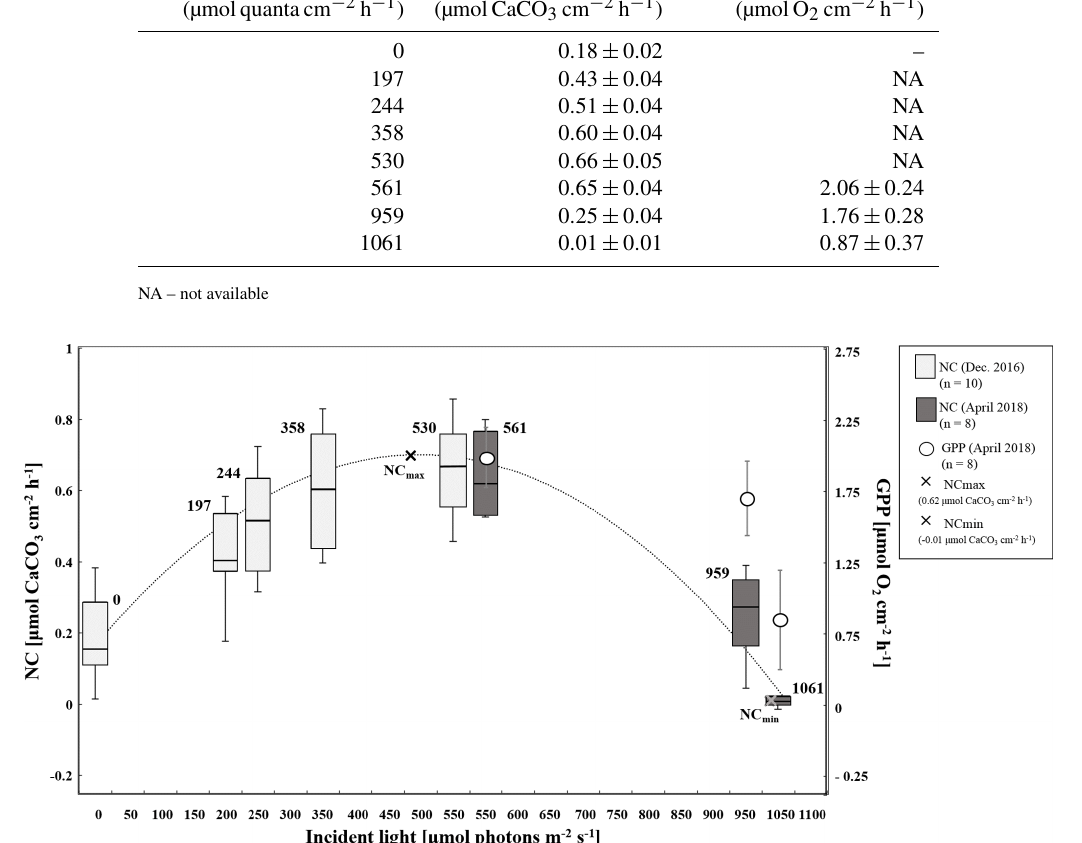
Figure 3. Boxplots showing net calcification rates (µmolCaCO 3 cm − 2 h − 1 ) of T. maxima under seven different light regimes (197, 244, 358, 530, 561, 959, and 1061µmolquantam − 2 s − 1 ) ( n = 10 in December 2016 and n = 8 in April 2018) and in the dark, as well as